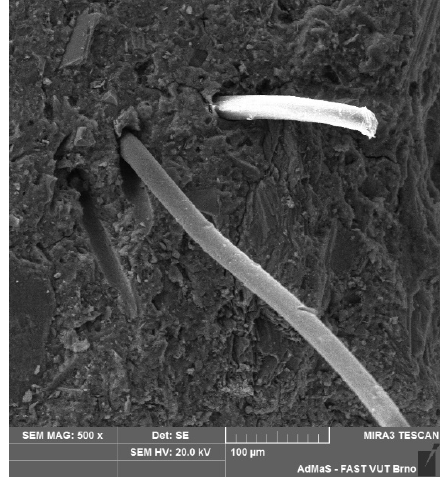
Figure 10. REC 2–20 °C (500×).